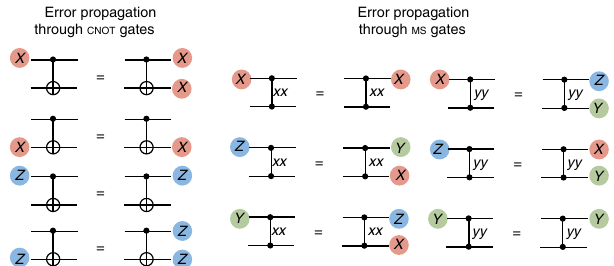
FIG. 4. Error propagation through CNOT and MS gates. (Left panel) An incoming Pauli error of the X ( Z ) type at the control (target) qubit propagates onto a target (control) error of the same X ( Z ) type after a CNOT gate. Conversely, an incoming Pauli error of the Z ( X ) type at the control (target) qubit does not propagate into the target (control) qubit. (Right panel) Error propagation through an MS gate up to phase factors irrelevant for fault-tolerant arguments. The left column corresponds to XX -type MS gates X 2 , whereas the right column describes YY -type MS gates Y 2 i;j Pauli errors that anticommute with the MS -gate basis are rotated and propagated to the other qubit. Pauli errors in the same MS - gate basis do not